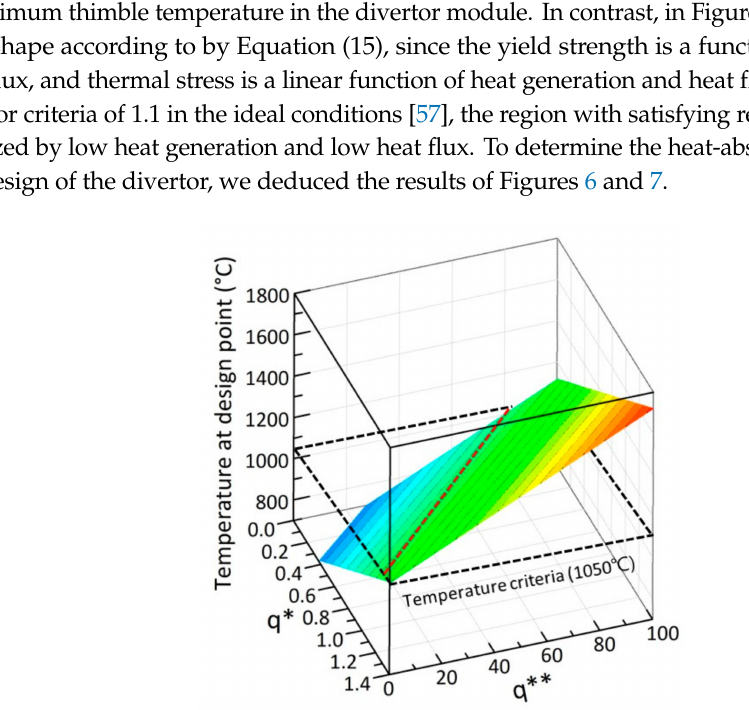
Figure 6. 3D thermal design map of maximum thimble temperature with changes in normalized heat flux ( q *) and heat generation ( q